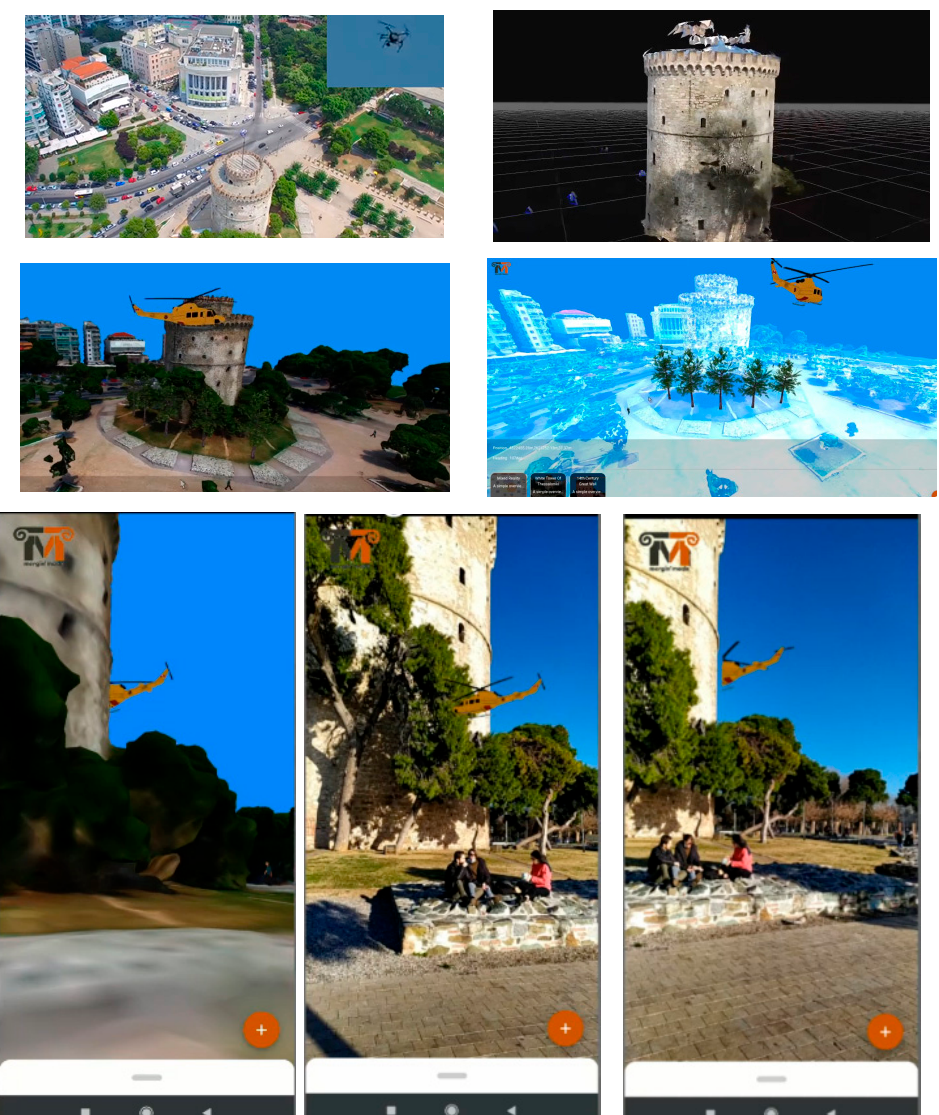
Figure 11. The top left picture showcases a popular data acquisition via UAVs and the top right the 3D mapping of a real object. The middle left picture contains the photogrammetrically mapped world and some virtual objects on it (helicopter, virtual men) while the middle right showcases the appliance of a blending technique towards the creation of the mixed world, with the virtual objects not being affected. The bottom pictures present the crucial differences between the three worlds: Virtual, Augmented and Mixed. The bottom left picture contains the mapped objects as obtained from acquiring physical data along with the generated virtual objects and all these form a digital world. The bottom middle picture contains the real world captured by the camera and presented in the visual display of the observer along with the virtual objects; however, no interaction between them exists, in terms of their relative position and potential occlusions, resulting in an augmented world. Finally, the bottom right picture provides the mixed world since the real objects have been transformed into mixed ones and have been perceived by the machine. Mixed objects are practically rendered transparent objects in sync with the real objects captured by the observer’s camera. (Notice the misalignment between the mixed and the virtual object). A YouTube video of the whole demonstration is available at: https://youtu.be/DyBLPymyEXI (accessed on 28 January 2021).